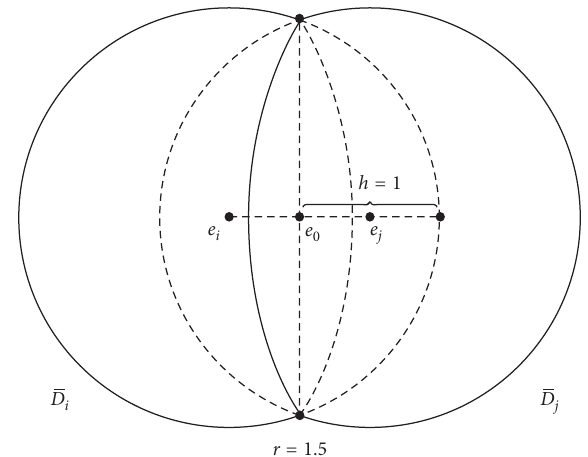
Figure 2: Two adjacent balls with centers e , e ) � 1 and the radius of the balls is d ( e i j